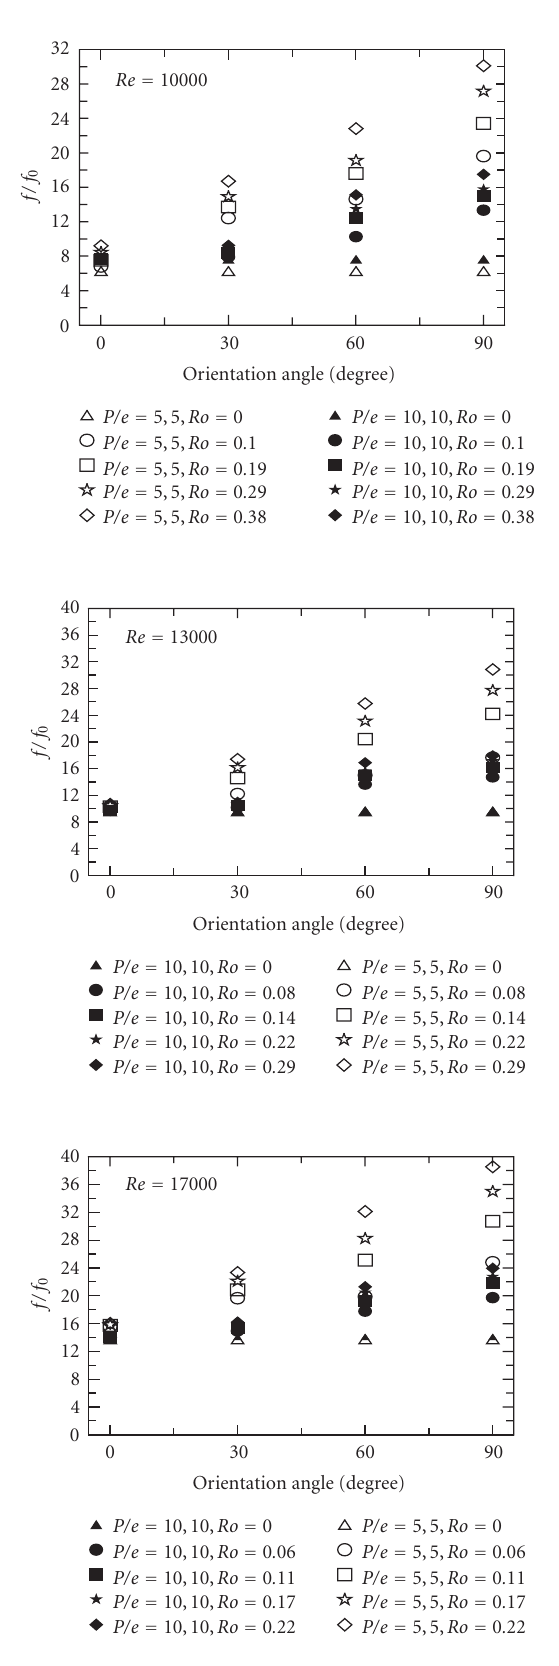
Figure 13: E ff ect of orientation angle in a rib-roughened rectangu- lar channel with detached ribs on two opposite walls.